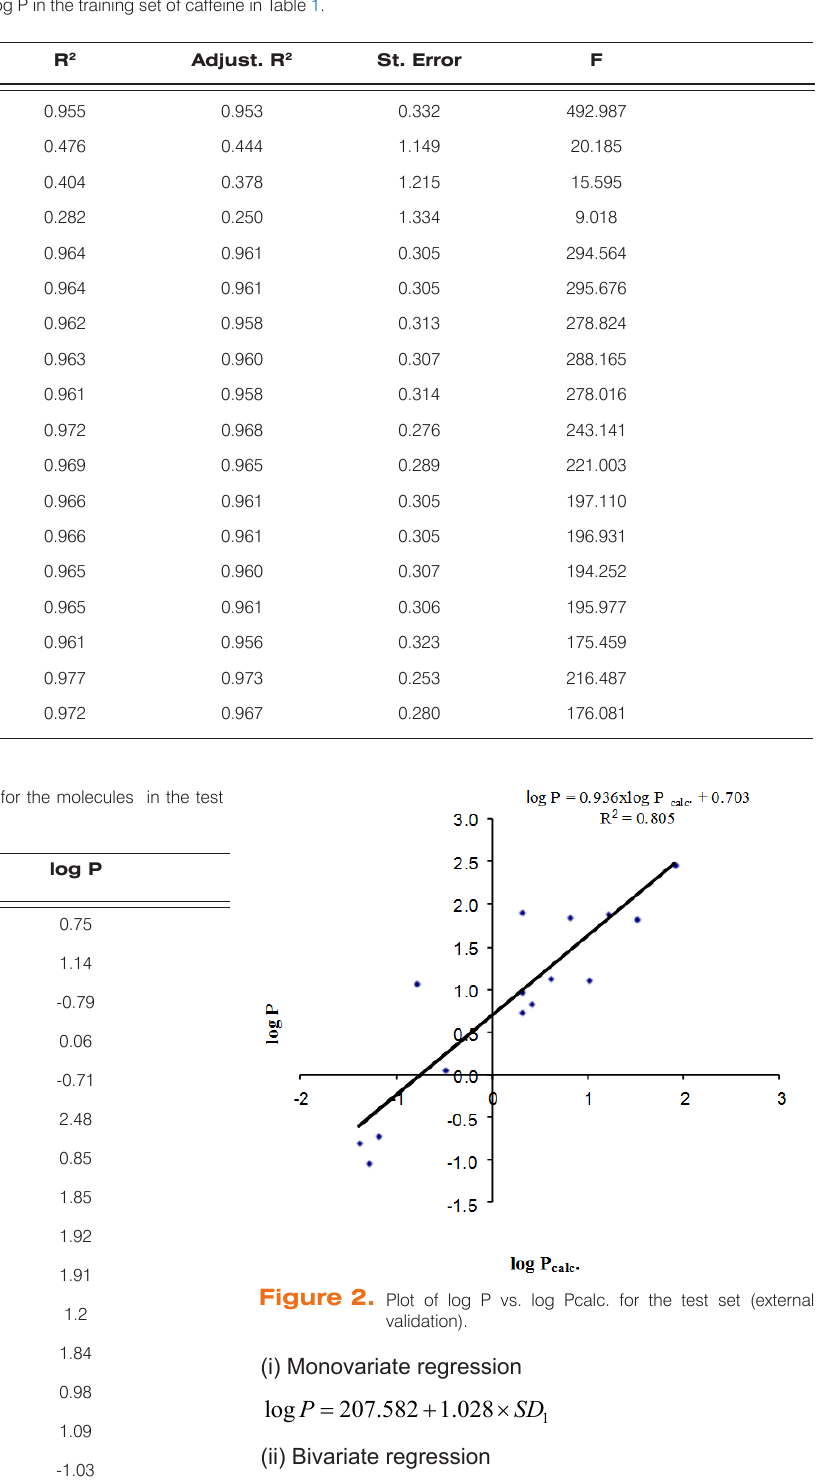
Table 4. Best models in describing log P in the training set of caffeine in Table 1.